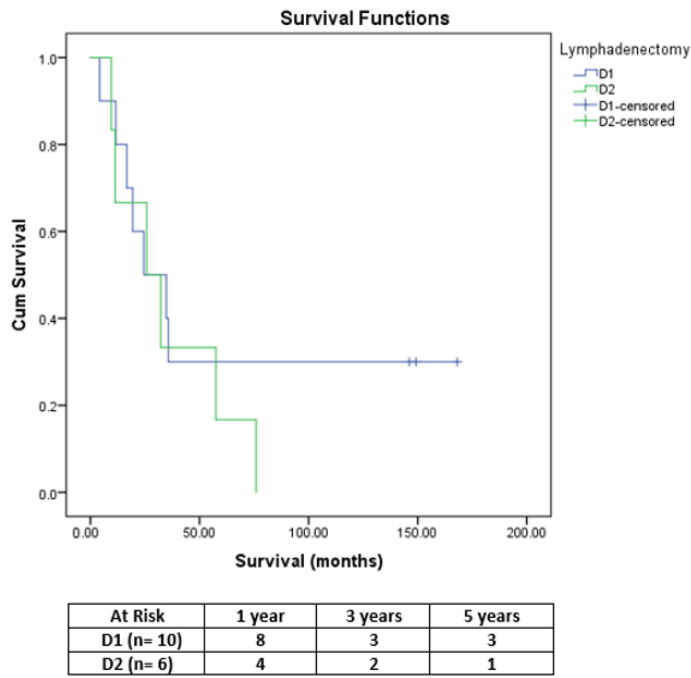
Figure 2. Comparative OS curves in SR group, according to the type of LND (D1 vs. D2) .